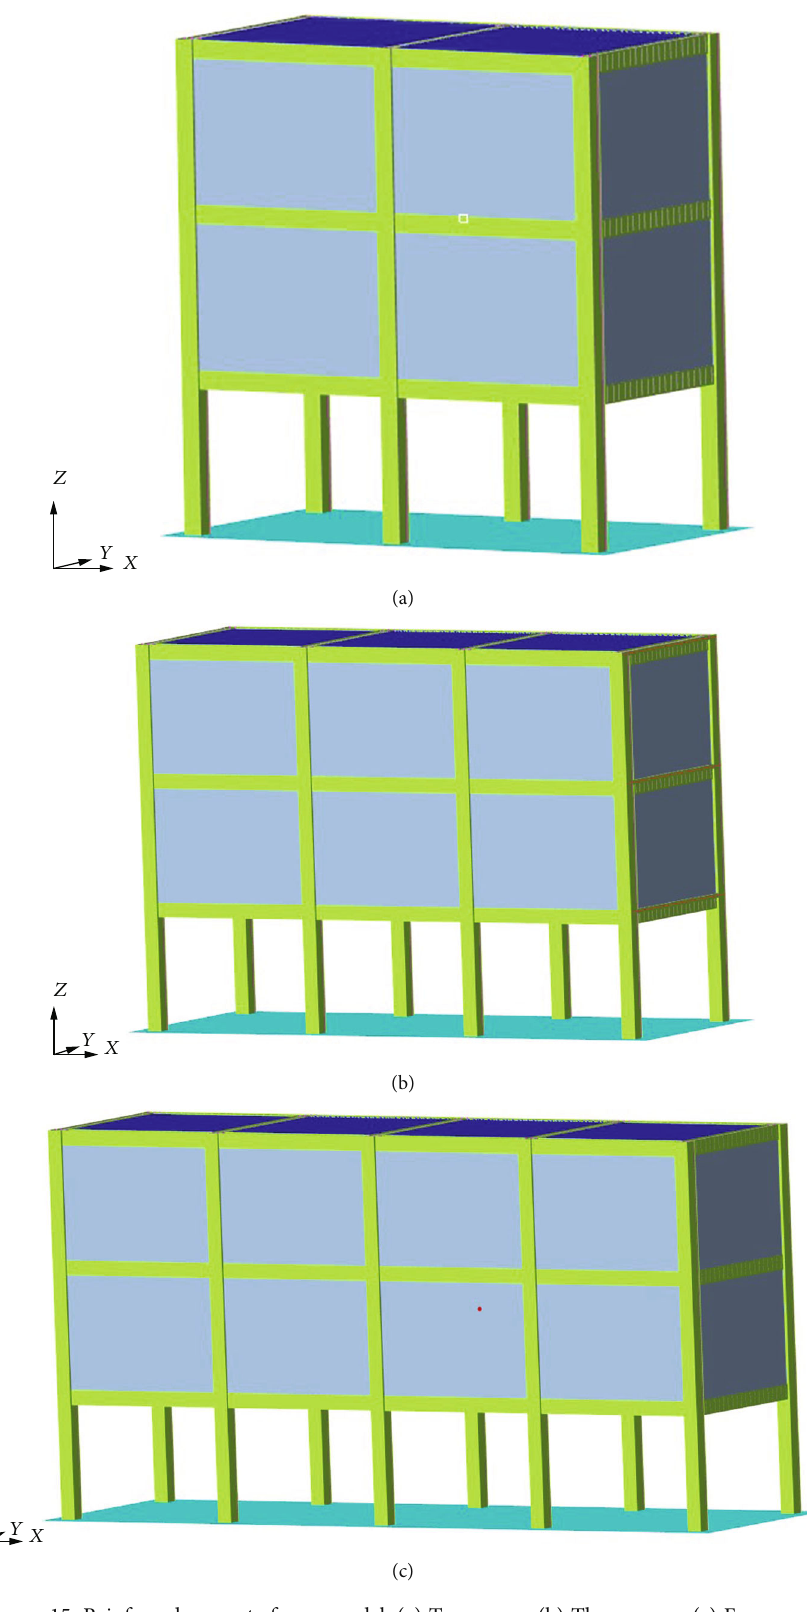
Figure 15: Reinforced concrete frame model. (a) Two spans. (b) Three spans. (c) Four